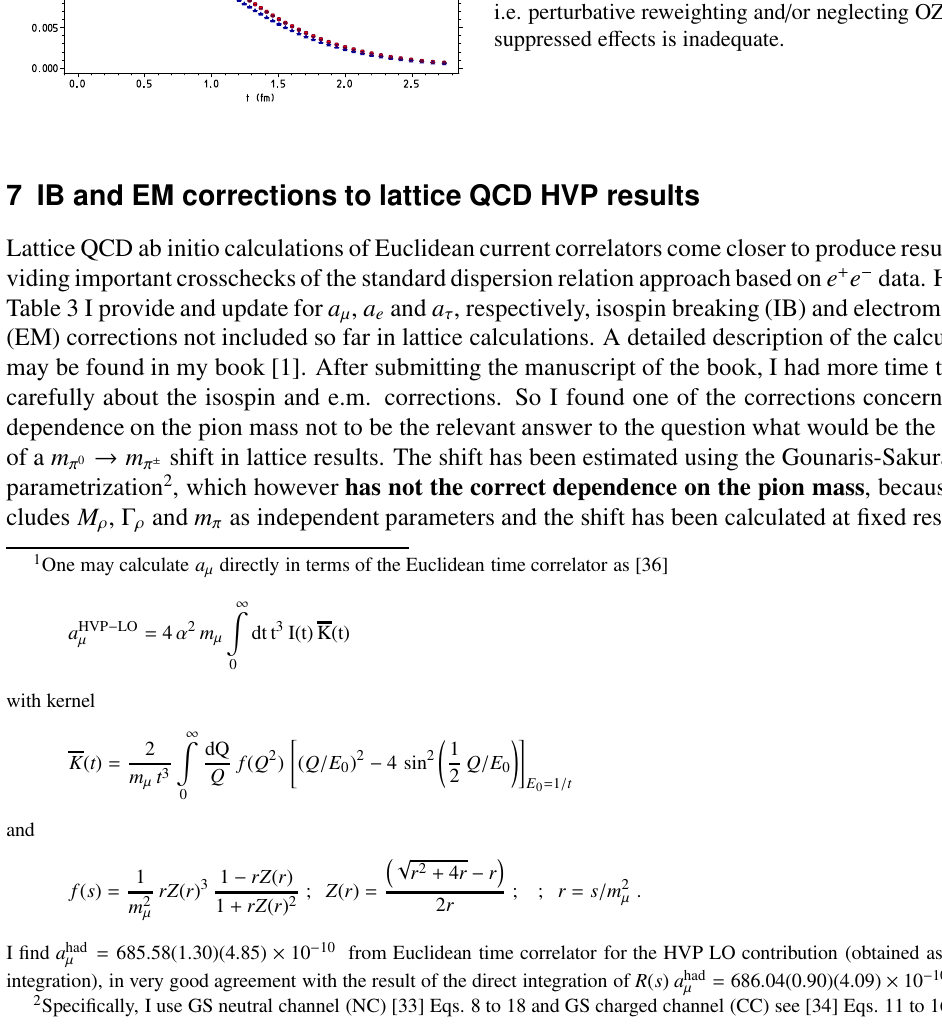
Figure 2. D γ 3 ( t ) versions of flavor separation a) VMD isovector, b) in the SU (2) and neglecting OZI suppressed terms = perturbative reweighting, with c) flavor separation in the SU (3) limit including OZI suppressed contributions. Version a) fits best to lattice data, c) shows also reasonable agreement, while b) is significantly o ff , i.e. perturbative reweighting and / or neglecting OZI suppressed e ff ects is